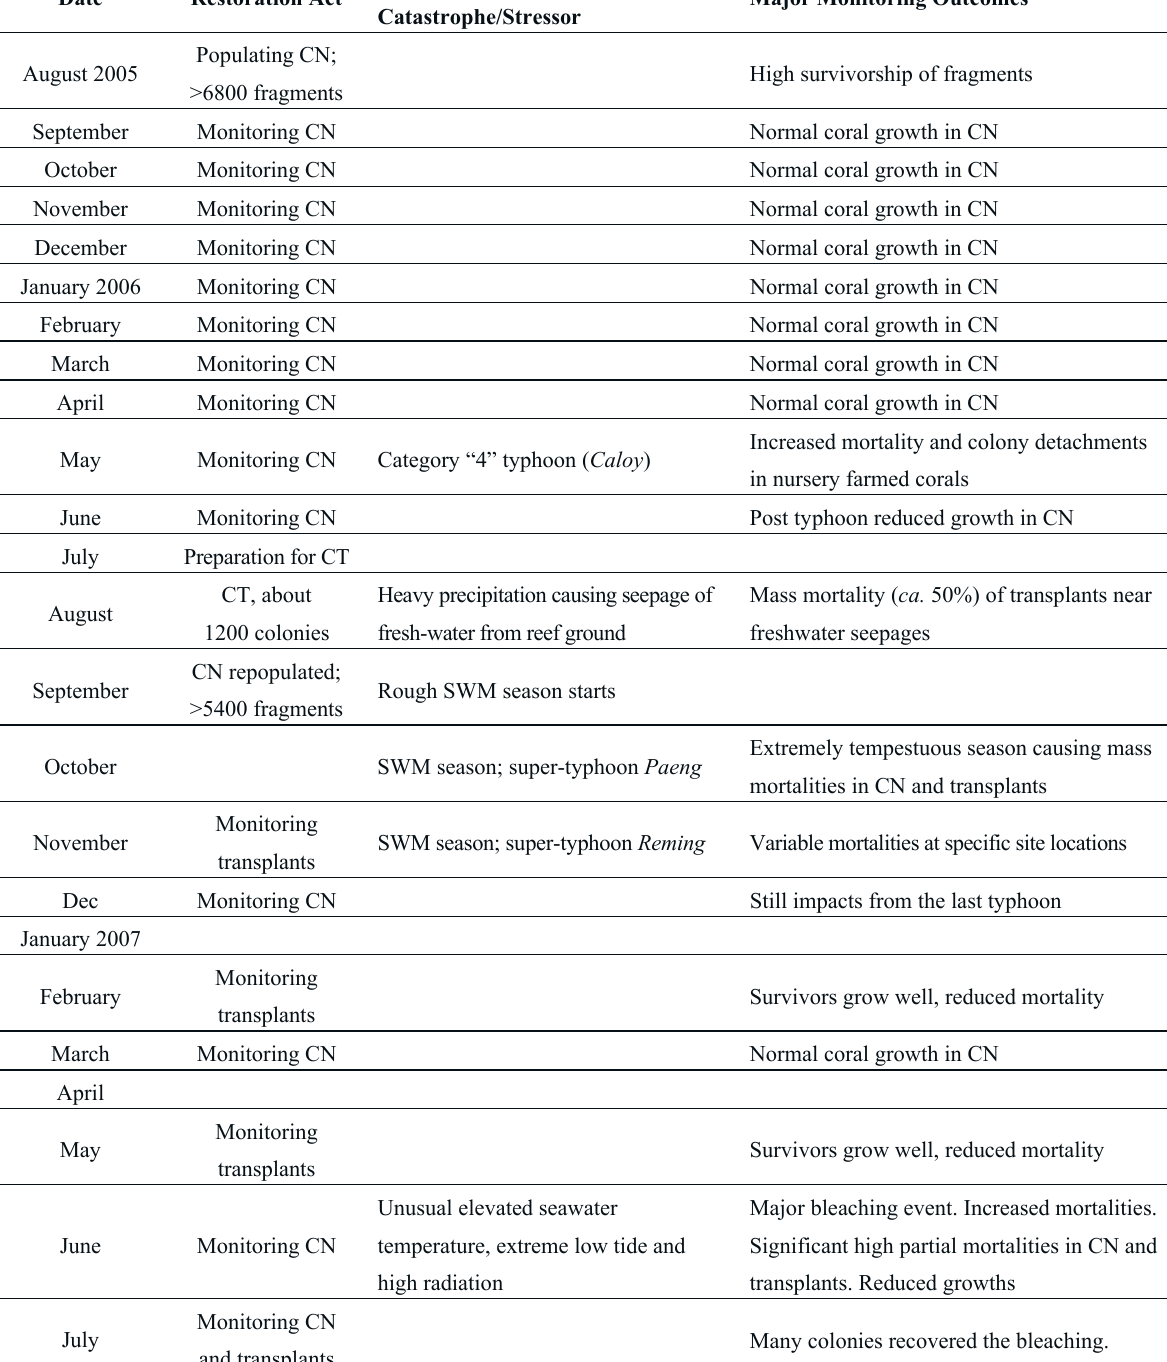
Table 1. Two years of follow-up outcomes of coral reef restoration activities (based on the “gardening” concept) in Bolinao (the Philippines), in the face of frequent natural catastrophes that represent anticipated global change impacts (following [31]). CN = coral nurseries; CT = coral transplantation; SWM—South-west